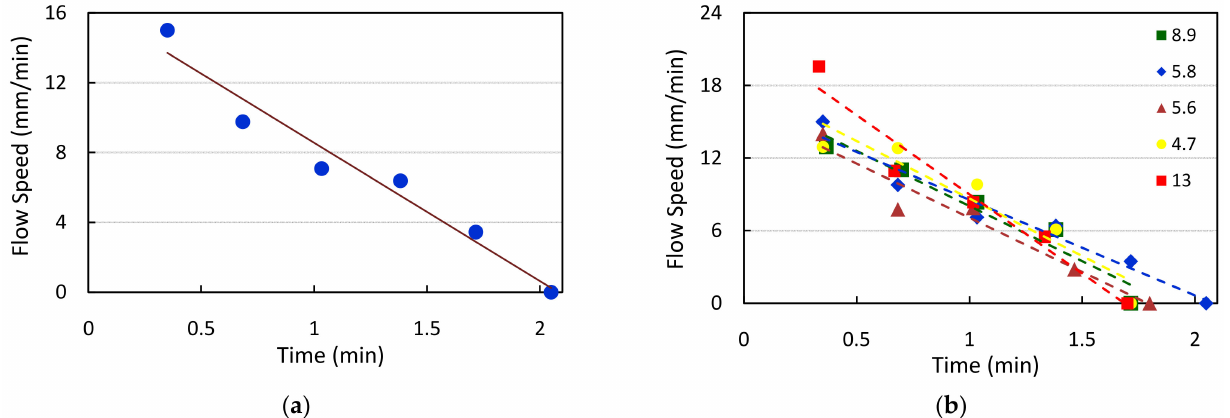
Figure 16. ( a ) The frame-to-frame variation in flow rate as captured for a single HbA1C test cartridge. ( b ) The trend of the frame-to-frame flow rates observed for different HbA1C test cartridges of varying